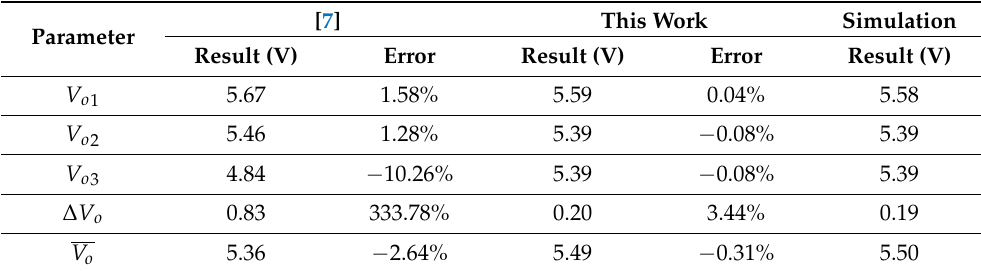
Table 3. The simulation result for 4 × cross-coupled charge